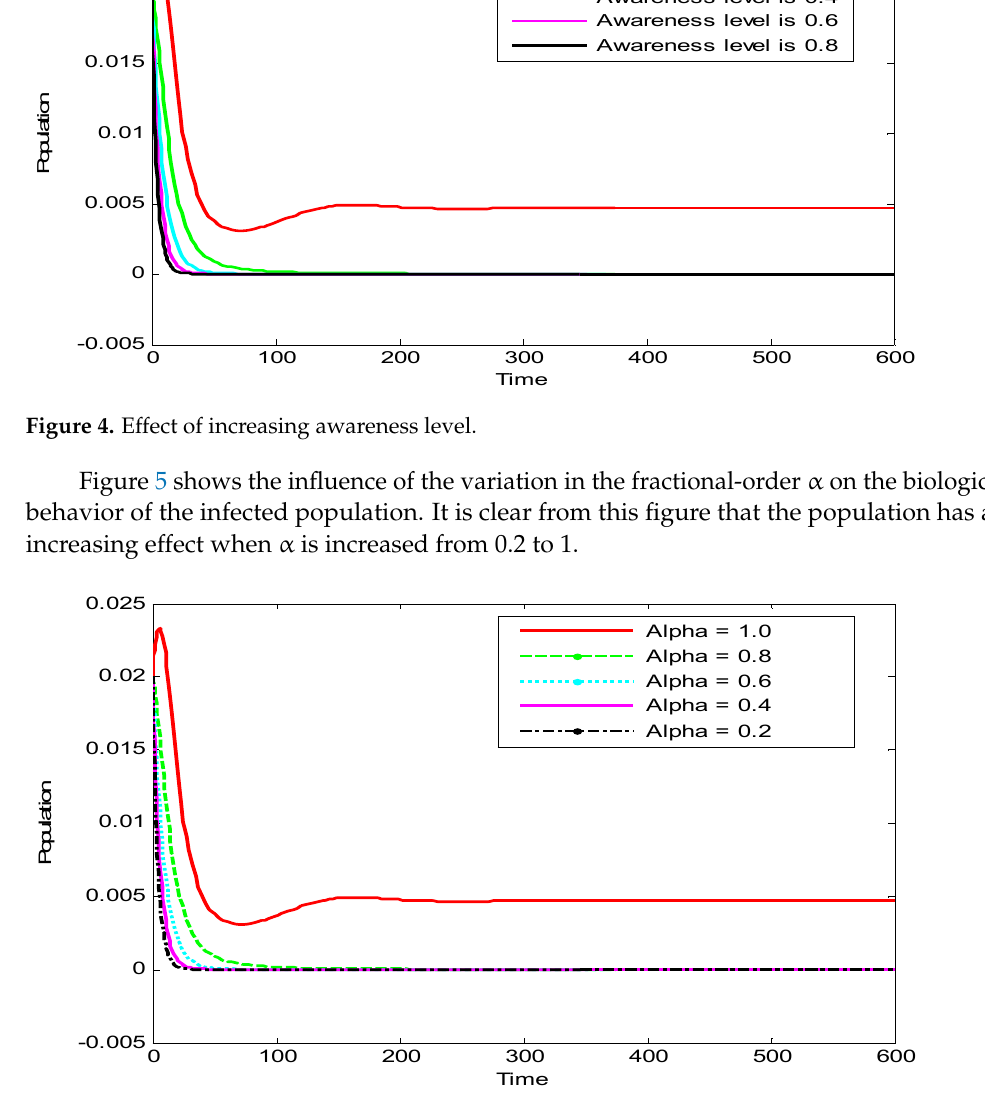
Figure 5. Dynamics of the infected population for various values of α .